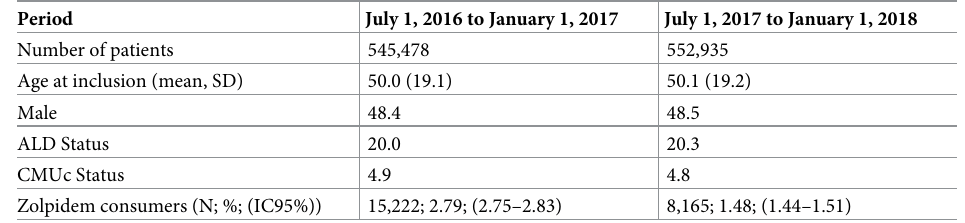
Table 1. Characteristics of the